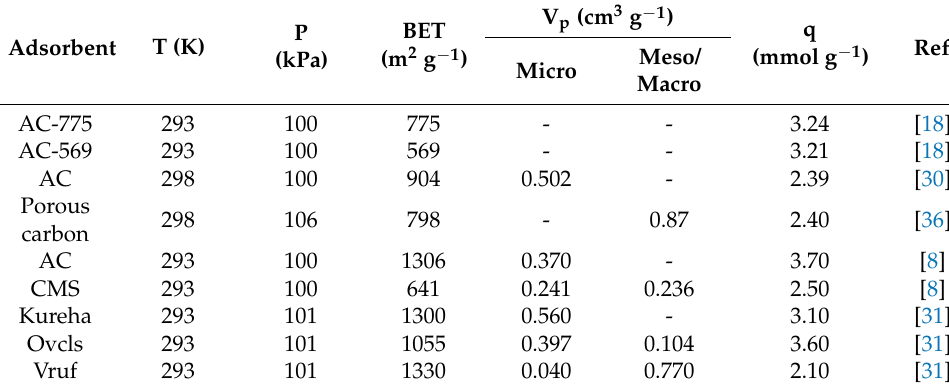
Table 3. Carbon-based materials in N 2 O adsorption studies.